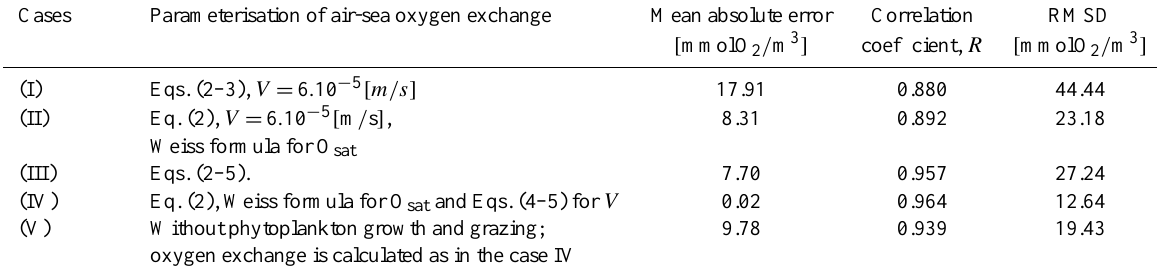
Table 1. The impact of the air-sea oxygen exchange parameterisation and primary production on surface oxygen concentrations.